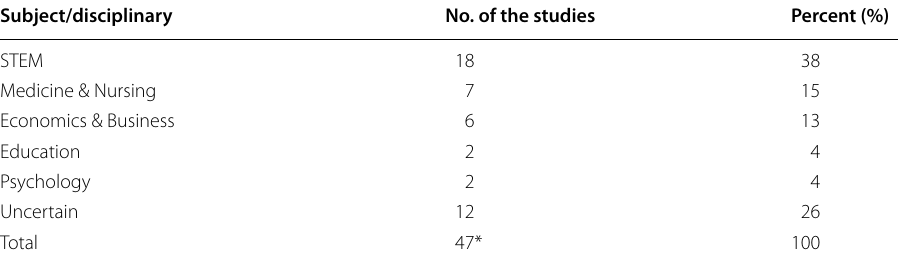
Table 4 Summary of subject areas addressed in the